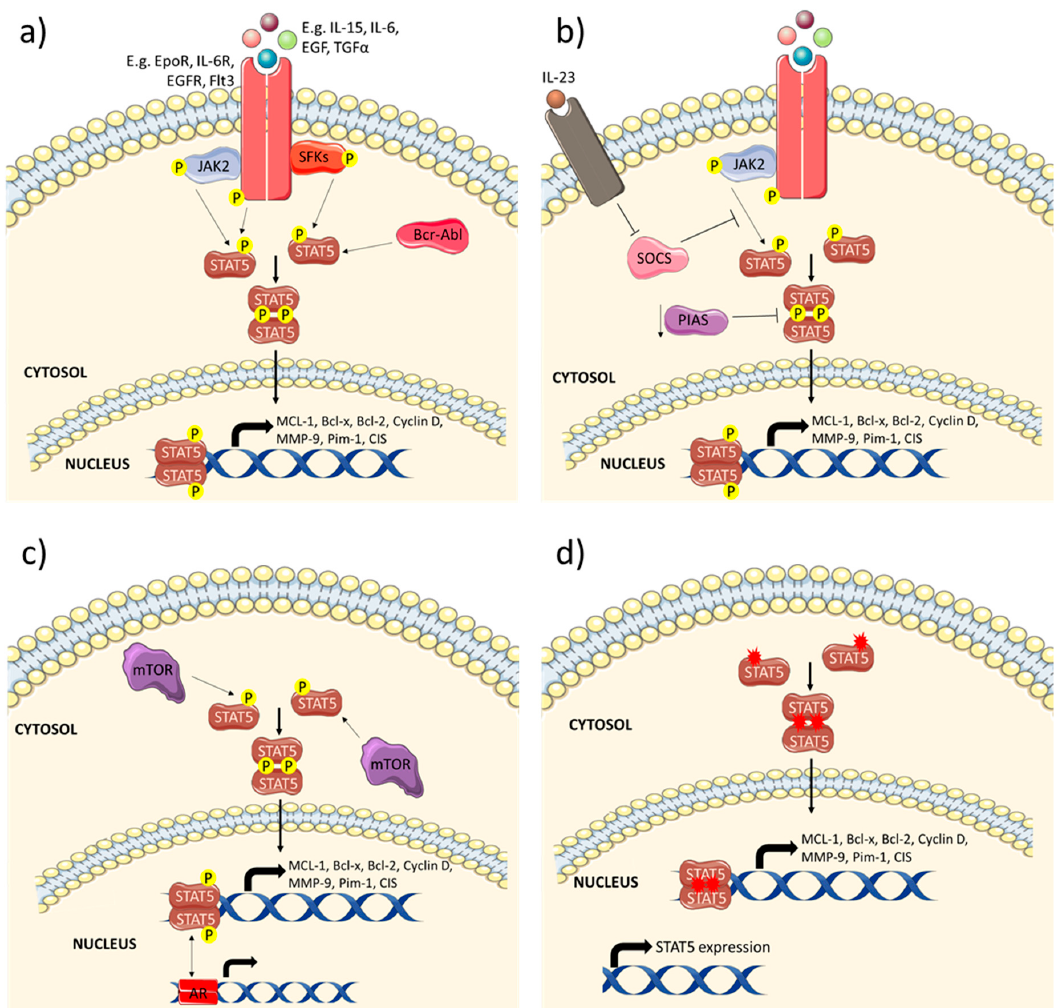
Figure 3. Mechanism of constitutive activation of STAT5. STAT5 is activated by: ( a ) increased signalling by cytokines and their receptors (interleukin-15 (IL-15), IL-6, erythropoietin receptor (EpoR), and IL-6 receptor (IL-6R)), receptor tyrosine kinases (RTKs), e.g., epidermal growth factor receptor (EGFR), and Flt3, as well as non-receptor tyrosine kinases (nRTKs), such as Src family kinases (SFKs), JAK2 and Bcr-Abl; ( b ) downregulation of negative regulators of STAT5 pathway, e.g., SOCS inhibited through IL-23 signalling and PIAS; ( c ) cross-talk with other signalling pathways, e.g., mammalian target of rapamycin (mTOR) and androgen receptor (AR) pathways; and ( d ) activating STAT5 mutations and increased STAT5 expression. Table 1. The role of STAT5 as either a tumour suppressor or an oncogene in various cancers, and its e ff ects in promoting cancer progression. E ff ects of the Status STAT5 in the Various Cancers